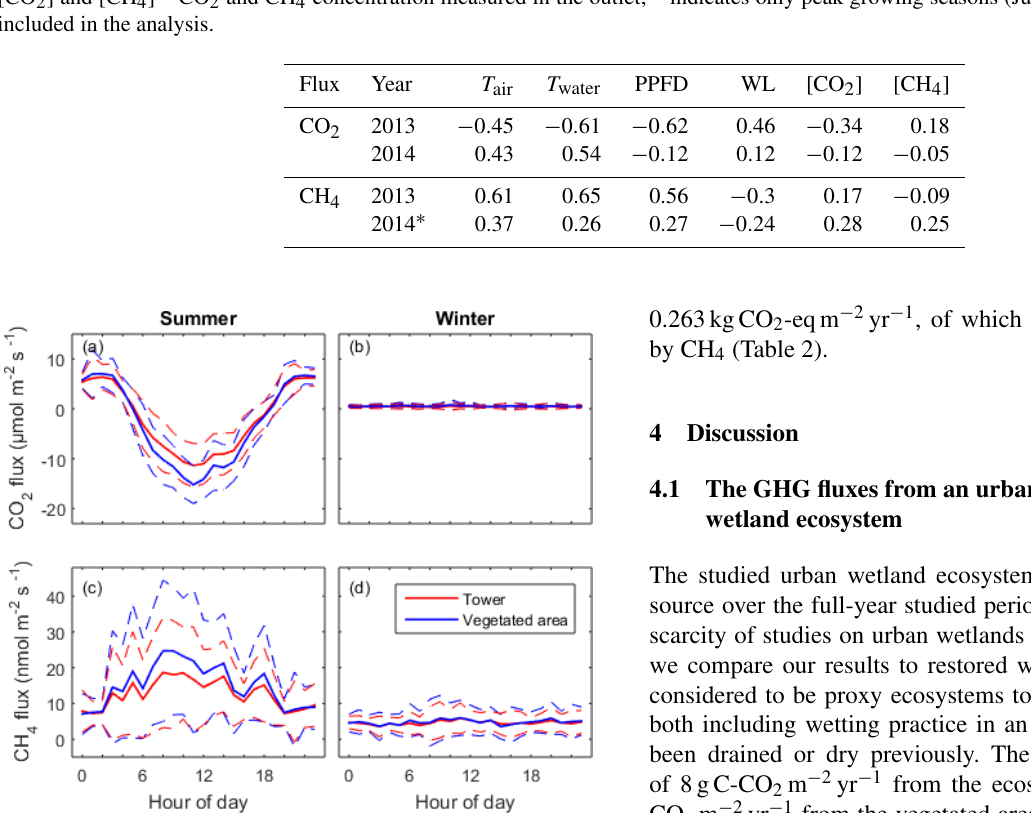
Figure 6. Mean diel pattern of the half-hourly net CO 2 and CH 4 fluxes in summer (a, c) and in winter (b, d) . The dashed lines rep- resent the standard deviation. Red lines indicate measurement from the EC tower and the blue lines show the fluxes modelled for the vegetated